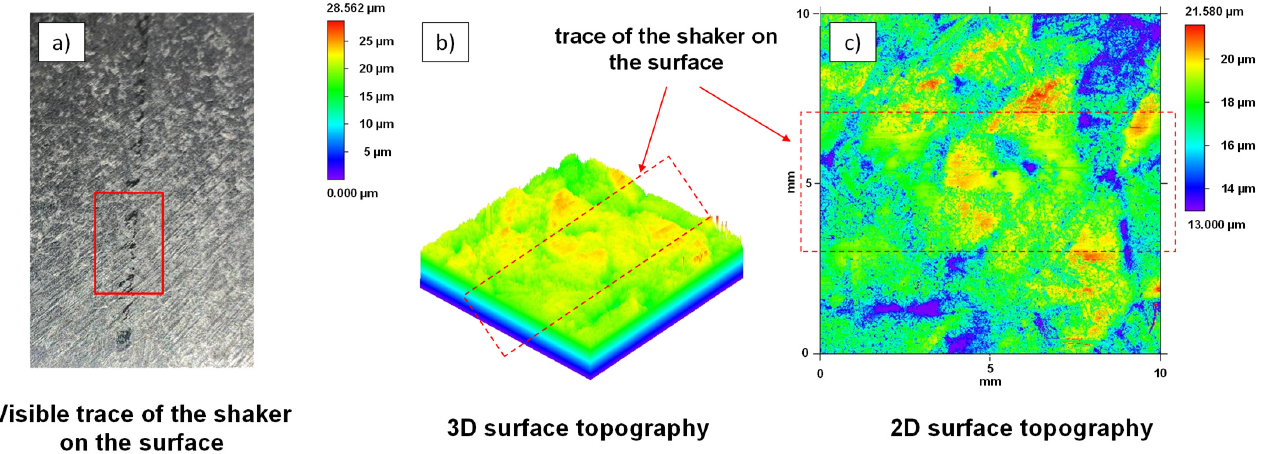
Figure 5. ( a ) Macroscopy overview of the sheet surface to inspect the piezoshaker-trace and ( b , c ) surface topography measurement of the sheet surface marked in ( a ) using WLI.